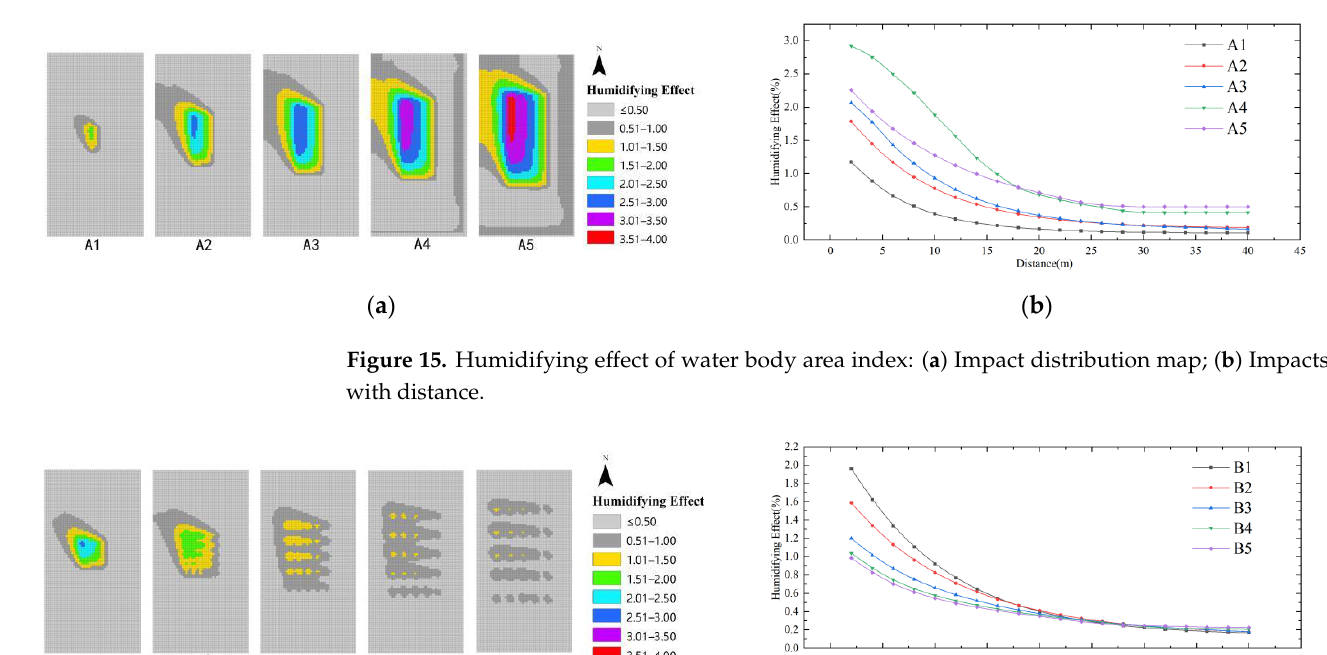
( b ) Figure 13. Cooling effect of the water body dispersion index: ( a ) Impact distribution map; ( b ) Im- pacts with distance. As shown in Figure 14, the cooling effect of the model scheme at the same distance is C1 ＞ C2 ＞ C3 ＞ C4 ＞ C5. The minimum cooling value is 0.1 regardless of the vari- ation of the shape index. The maximum cooling effect of the water body shape index (C) is 0.75 °C, and the farthest influence distance is 36 m. The cooling distance of model schemes C1 – C5 are 36 m, 32 m, 28 m, 24 m, 20 m, and the cooling distance of C1 is the farthest. It can be seen that the more aggregated the water body shape, the better the cool- ing effect; in which case C1 has the best cooling effect and the longest distance, 36 m. ( a ) ( b ) Figure 14. Cooling effect of the shape index of the water body: ( a ) Impact distribution map; ( b ) Impacts with distance. 3.2.2. Humidifying Effect The humidifying effect of the water body layout model in summer is shown in Figure 15. The humidifying effect of the water body area index (A) is 4%, and the farthest influ-